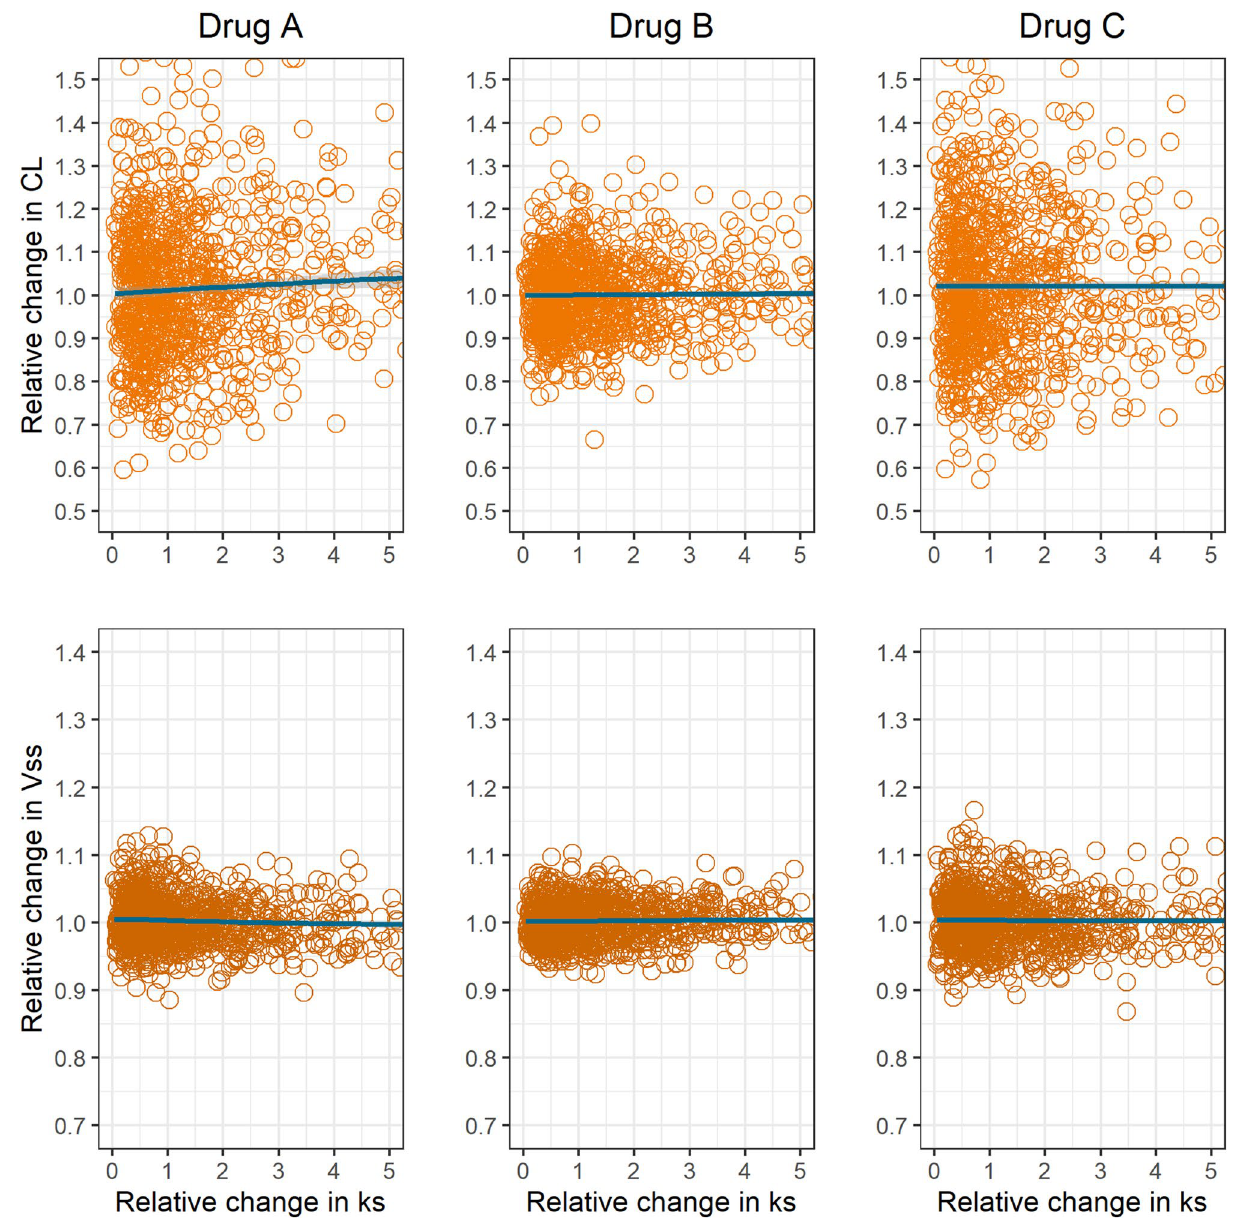
Figure 6. Sensitivity analysis with variability in all first-order rate constants, shown as scatterplots, for the mean impact of drug gastric secretion first-order rate constant ( k s ) on systemic clearance (CL) and volume of distribution at steady state